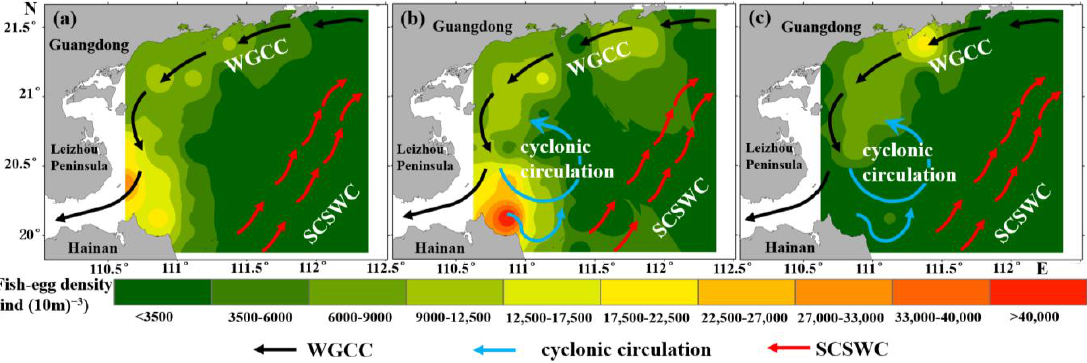
Figure 6. Spatial distribution of the ocean currents and fish eggs in WGWs: ( a ) April, ( b ) May, and ( c ) June (arrow direction represents the current direction). Black arrow, western Guangdong coastal current (WGCC); blue arrow, cyclonic circulation; and red arrow, South China Sea warm current